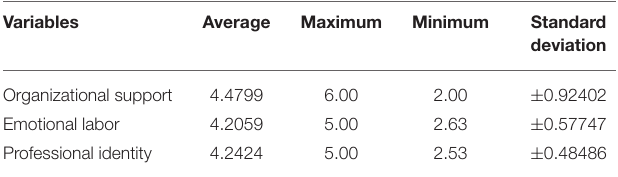
TABLE 5 | Descriptive statistics of main variables.